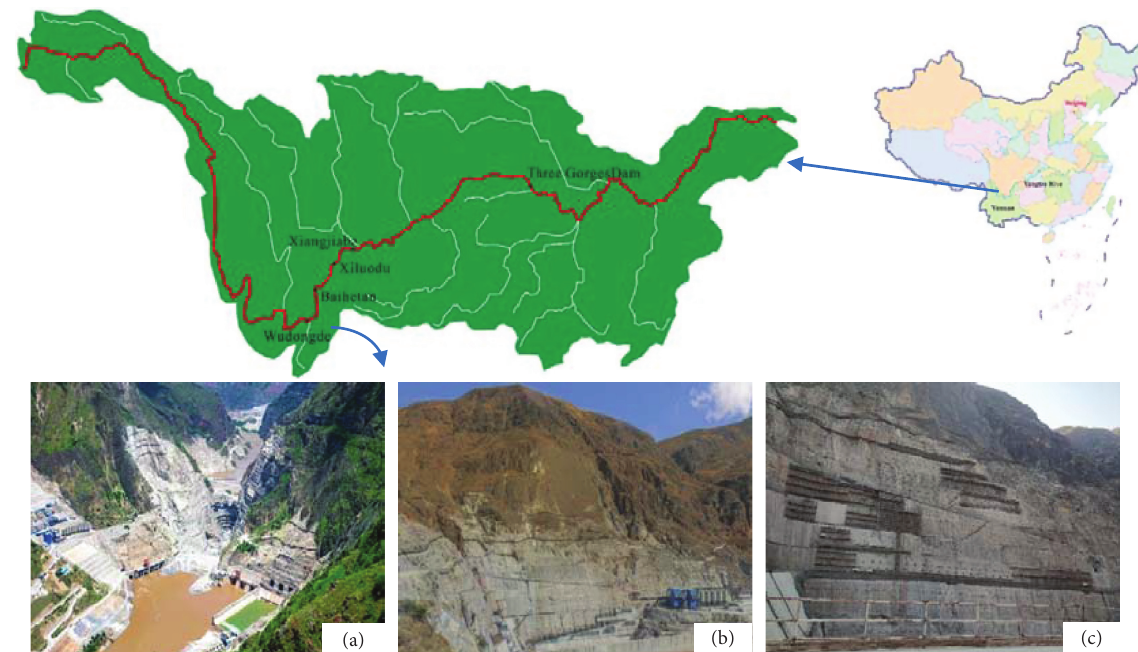
Figure 1: Geographical location and field characteristics of Wudongde hydropower